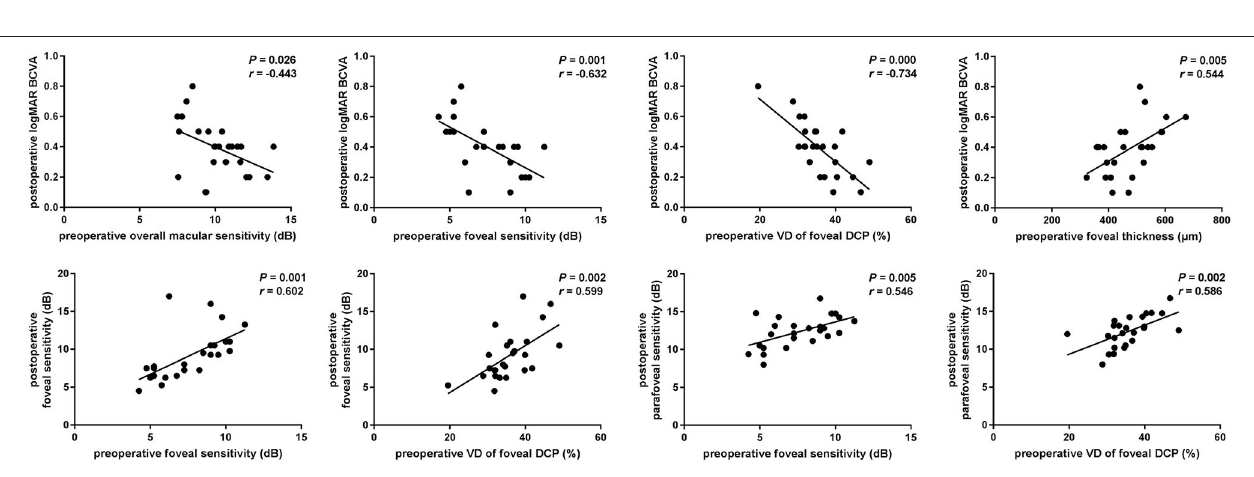
FIGURE 3 | Associations of postoperative visual function and preoperative parameters. Scatterplots show the statistically significant correlation between postoperative logMAR BCVA and preoperative macular or foveal sensitivity, vessel density (VD) of foveal SCP and CFT ( r = − 0.443, P = 0.026; r = − 0.632, P = 0.001; r = − 0.734, P < 0.001; r = 0.544, P = 0.005). Postoperative foveal or parafoveal sensitivity was significantly correlated with preoperative foveal sensitivity and vessel density of foveal DCP ( r = 0.602, P = 0.001; r = 0.599, P = 0.002; r = 0.546, P = 0.005; r = 0.586, P =